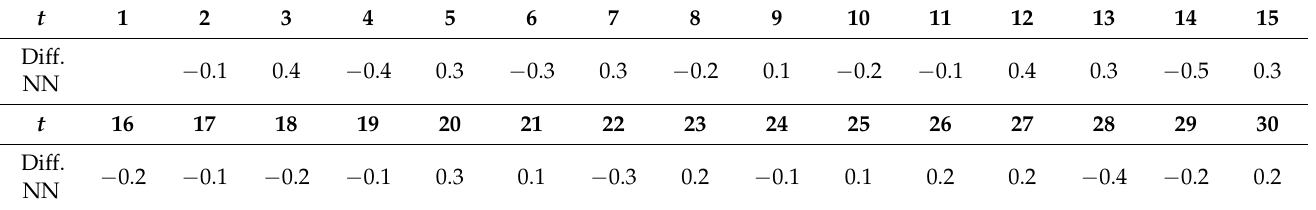
Figure 6. Transformation from MD to NN state of series. By the first difference of the NN state of the series, we obtain stationary time series, as is shown in Table 9 and Figure 7. Table 9. First difference of NN state of the series. Table 9. First di ff erence of NN state of the series.